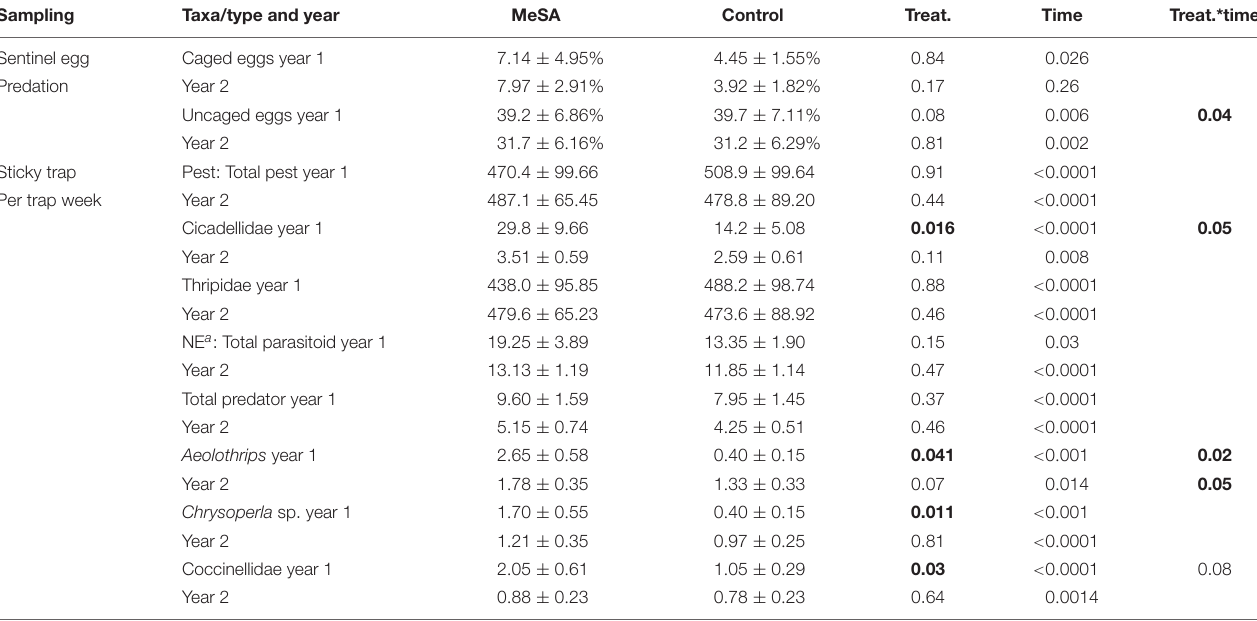
TABLE 4 | Mean (+SE) predation of sentinel H. halys eggs and counts of insects in nursery plots with and without MeSA lures, and p -values from GLMM. Sampling Taxa/type and year MeSA Control Treat. Time Treat.*time Sentinel egg